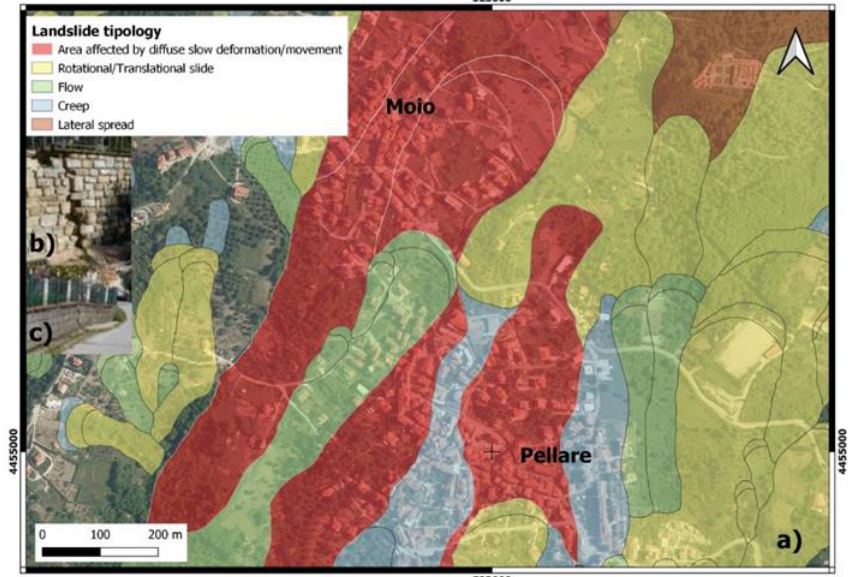
Figure 1 . Landslide inventory map (a) (Hydro-geomorphological Setting Plan, South Campania River Basin Authority, 2015) and some examples of damage recorded to infrastructures within the test area (b,